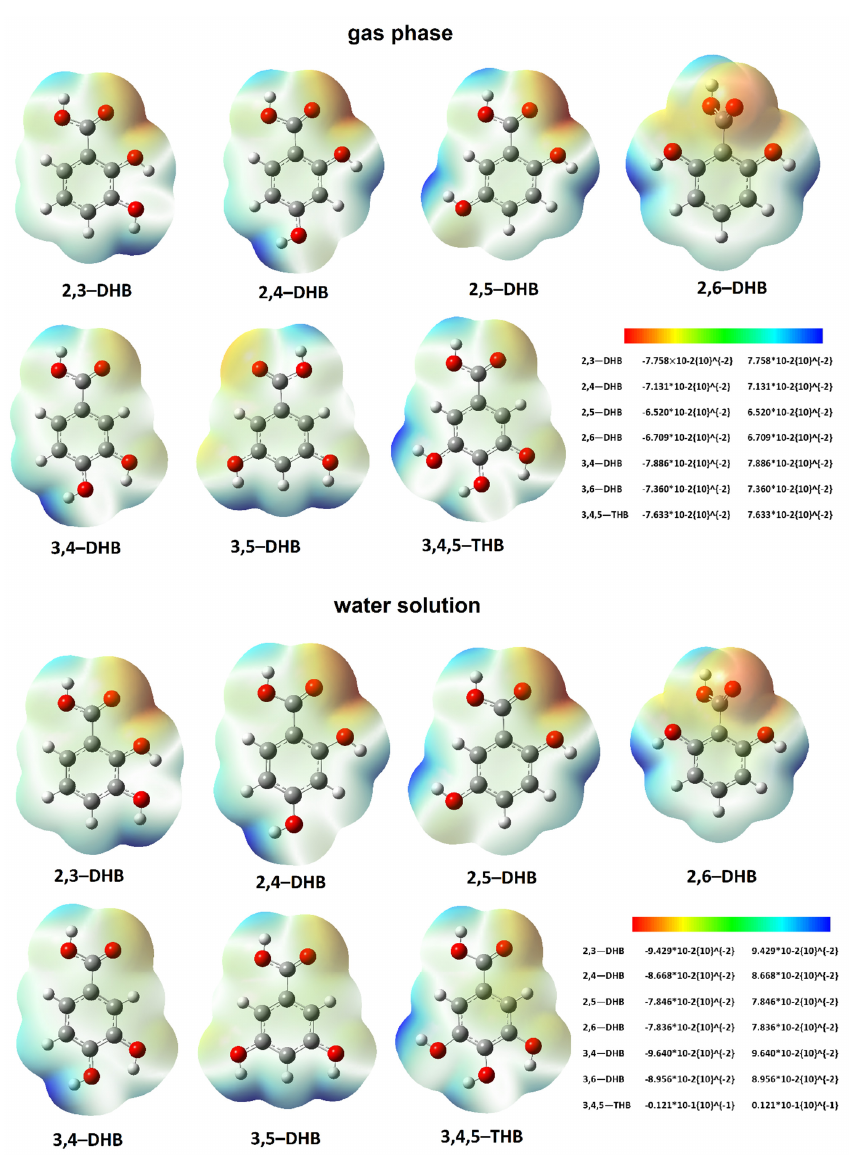
Figure 8. Electrostatic potential maps (calculated via the CHelpG method in B3LYP/6-311++G(d,p) for dihydroxybenzoic acids and 3,4,5-trihydroxybenzoic acid (in the gas phase and water solution).